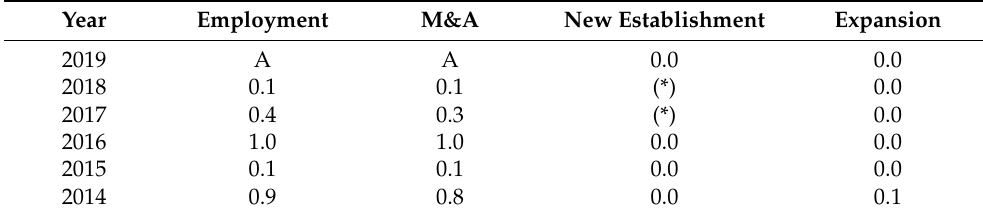
Table 2. Employment of Foreign-Owned Businesses Acquired, Established, and Expanded in New Hampshire, 2014–2019 (1000